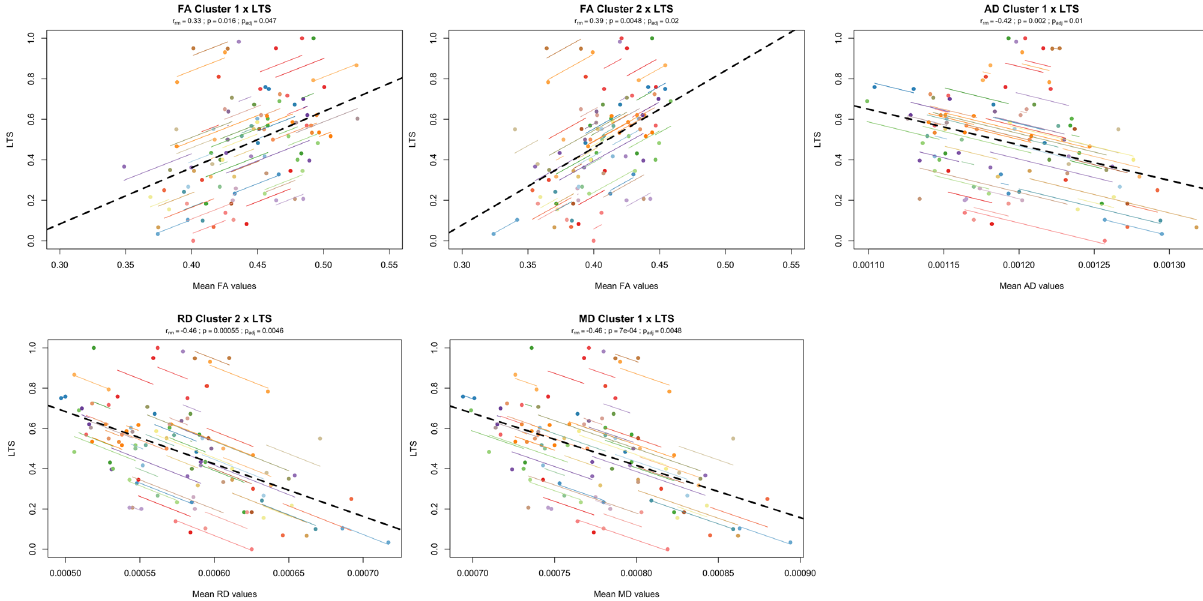
Figure 3. Significant repeated measures correlations between long-term storage (LTS) test score and DTI metrics (FA, AD, RD and MD) of clusters with significant changes between timepoints. The x-axis represents average values of each DTI metric and y-axis, the average values of LTS. Observations from the same individual are represented with the same color, with corresponding lines showing the repeated measures correlation fit for each subject. Dashed black line represents the overall regression line. All clusters, with the exception of RD cluster 1, were significantly associated with LTS. For FA clusters, we found a positive correlation, meaning that higher FA values are associated with higher LTS scores. For AD, RD and MD clusters, a negative correlation was found, showing that lower AD, RD or MD values are associated with higher LTS scores. Overall, these results suggest that higher WM integrity is associated with higher cognitive performance in the memory